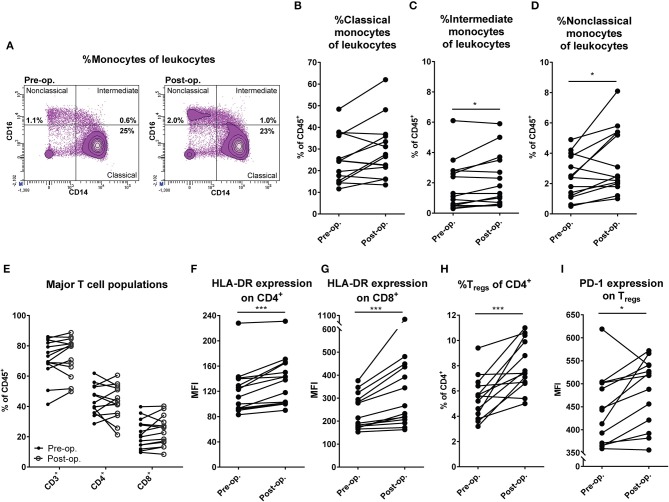
M-ILP triggers expansion of CD16+ monocytes and T cell activation. (A) Flow cytometry plots showing the gating strategy for non-classical (CD33+CD14+CD16++), intermediate (CD33+CD14++CD16+) and classical (CD33+CD14++CD16−) monocytes in peripheral blood before and after M-ILP in a representative patient. Percentage of (B) classical, (C) intermediate, and (D) non-classical monocytes among live CD45+ leukocytes in peripheral blood from melanoma patients before (pre-op) and 1 month after (post-op) M-ILP (n = 14). (E) Percentage of total T cells (CD3+), T helper cells (CD4+) and cytotoxic T cells (CD8+) among leukocytes in the peripheral blood of melanoma patients before and after M-ILP (n = 14). HLA-DR expression (median fluorescence intensity, MFI) on (F) CD4+ and (G) CD8+ T cells before and after M-ILP (n = 14). (H) Percentage of Tregs (CD3+CD4+CD25+Foxp3+) among CD4+ T cells and (I) Treg expression of PD-1 before and after M-ILP (n = 13, Wilcoxon matched-pairs test). *P ≤ 0.05, ***P ≤ 0.001.